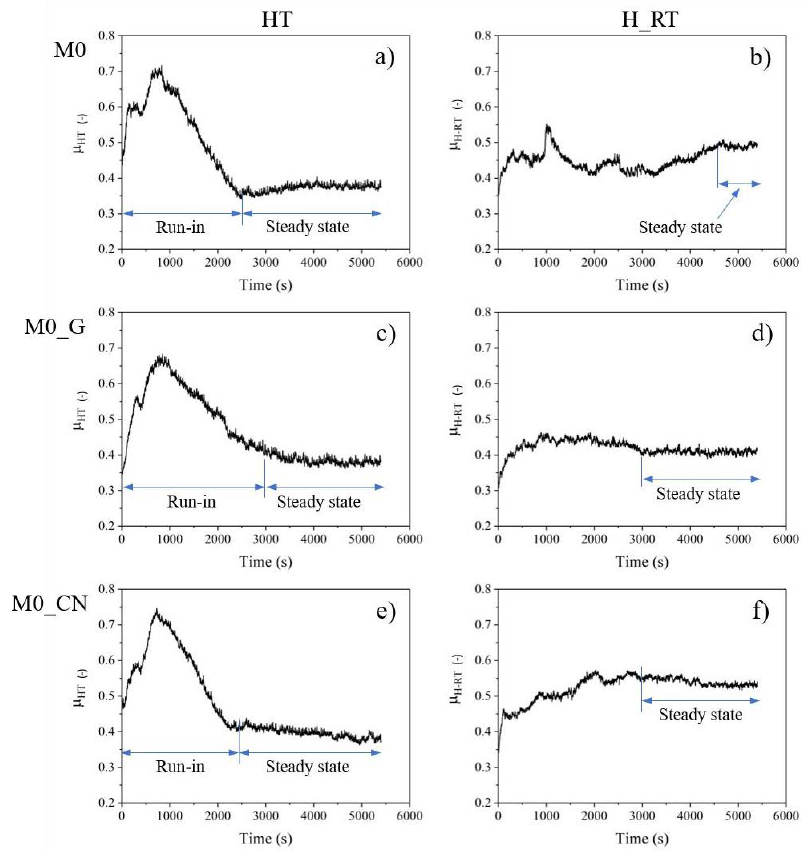
Figure 6. Evolution of the µ with time for the materials tested at high temperature (HT) and at RT after the HT tests (H_RT). ( a , b ) smaple M0, ( c , d ) M0_G, and ( e , f )